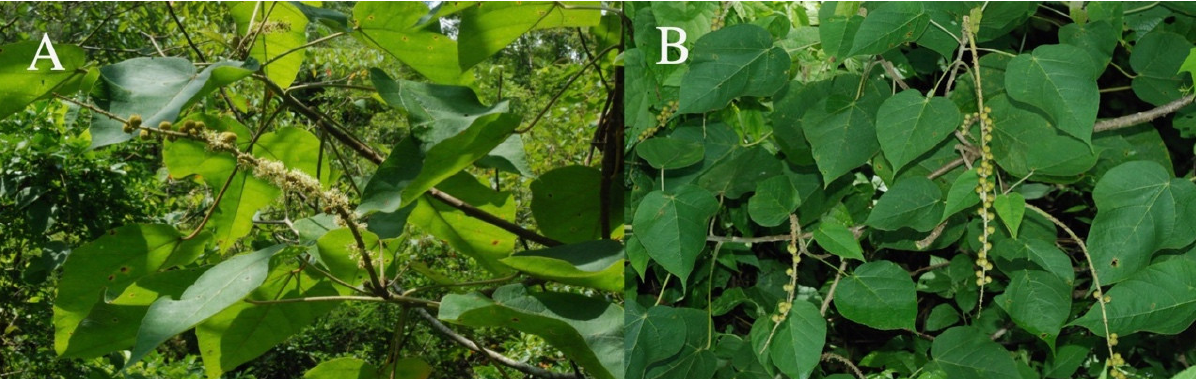
Figure A5. Croton suberosus. ( A ) Flowering branches. ( B ) Cocky lower stem. ( C – E ) Inflorescences.